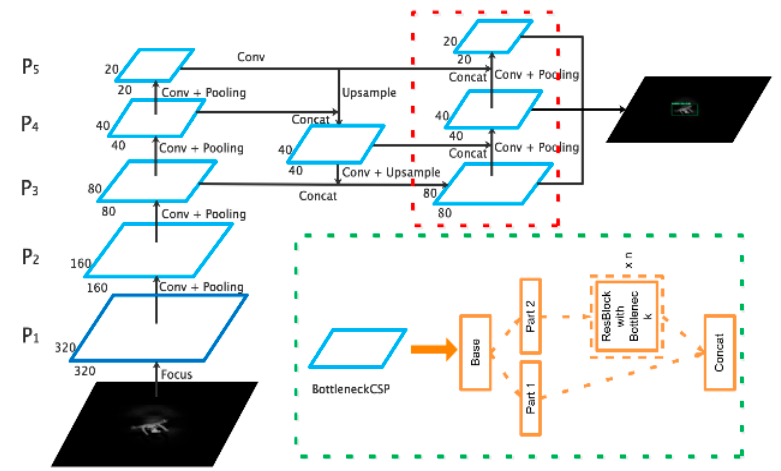
Figure 4. Illustrations of the YOLOv5s model [22]. There is a path augmentation structure in the red dotted box and a structural schematic diagram of the CSP module in the green dotted box. Table 1. Architecture of the YOLOv5s model [22].